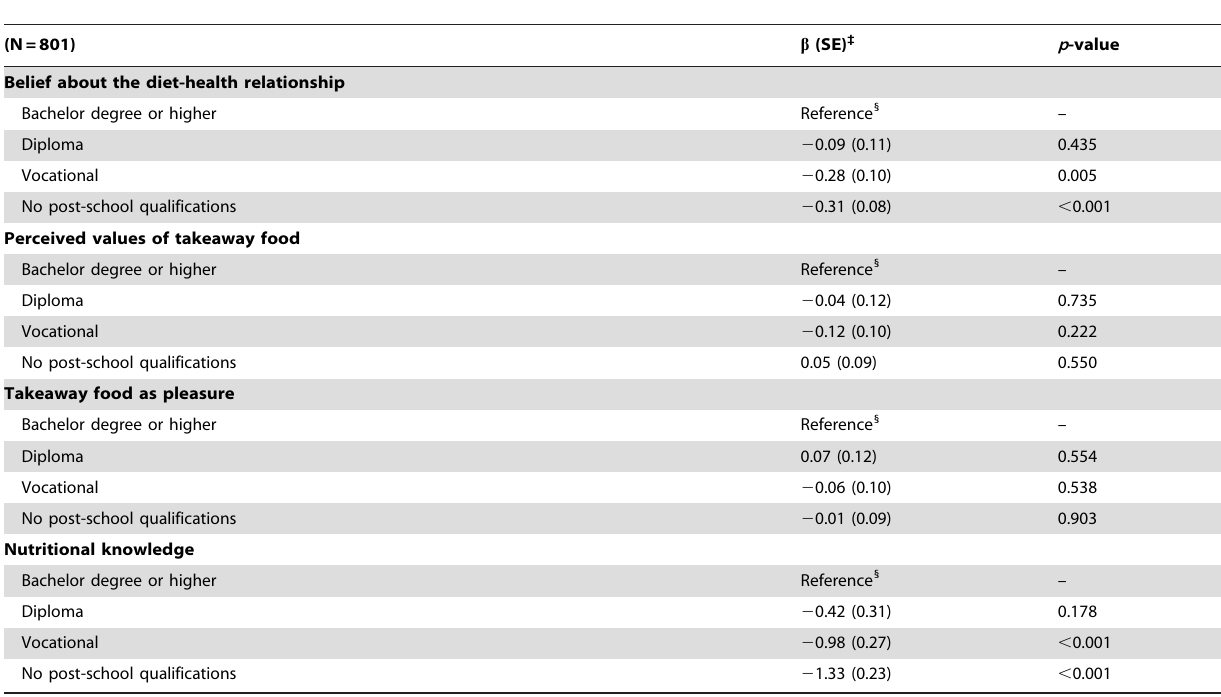
Table 3. Associations between education level and beliefs, perceptions and knowledge about diet, health, and takeaway food { .